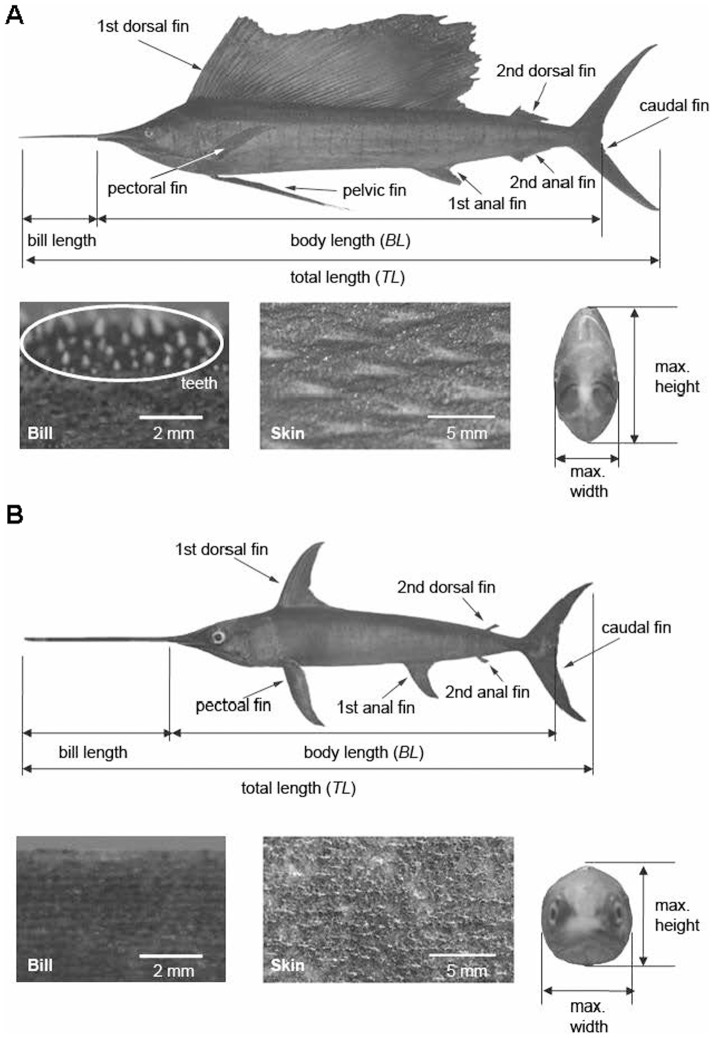
Taxidermy specimens used in the present study.In both A sailfish and B swordfish, the overall shape (top), enlarged views of bill (bottom and left) and skin (bottom and center), and frontal view of body (bottom and right) are shown.